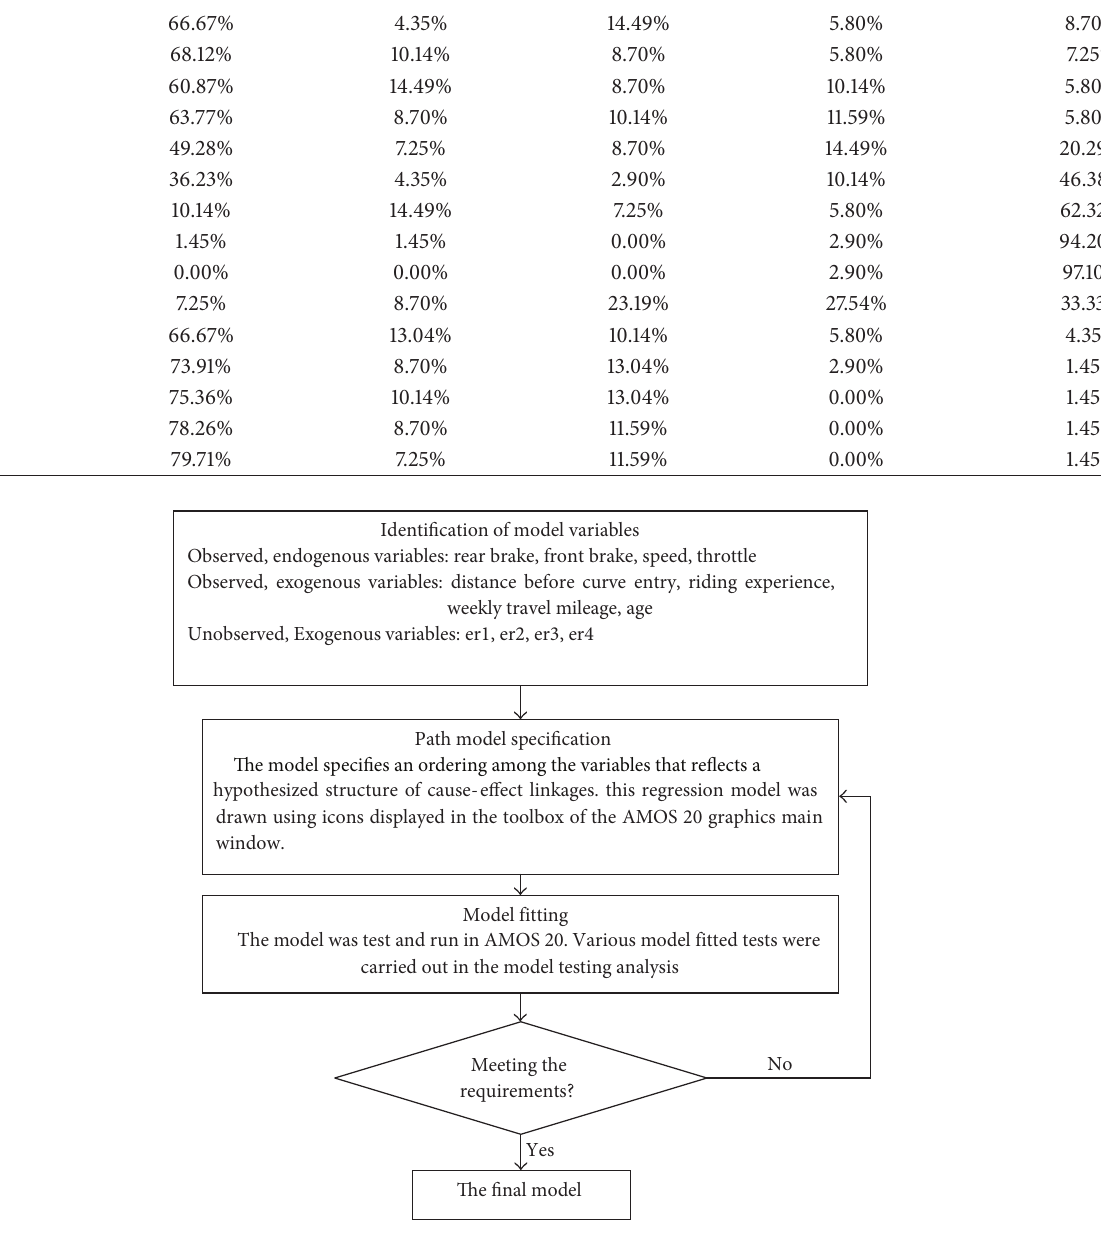
(IFI), Tucker-Lewis Index (TLI), and Comparative Fit Index (CFI) all range from 0.652 to 0.903 (Table 5). These indices compare the fit of the hypothesized model to the null or inde- pendence model. They range from 0 which means a fit that is no better than the null model to 1 which is a perfect fit. Given the range of the computed baseline comparisons fit indices, the model sufficiently fit the